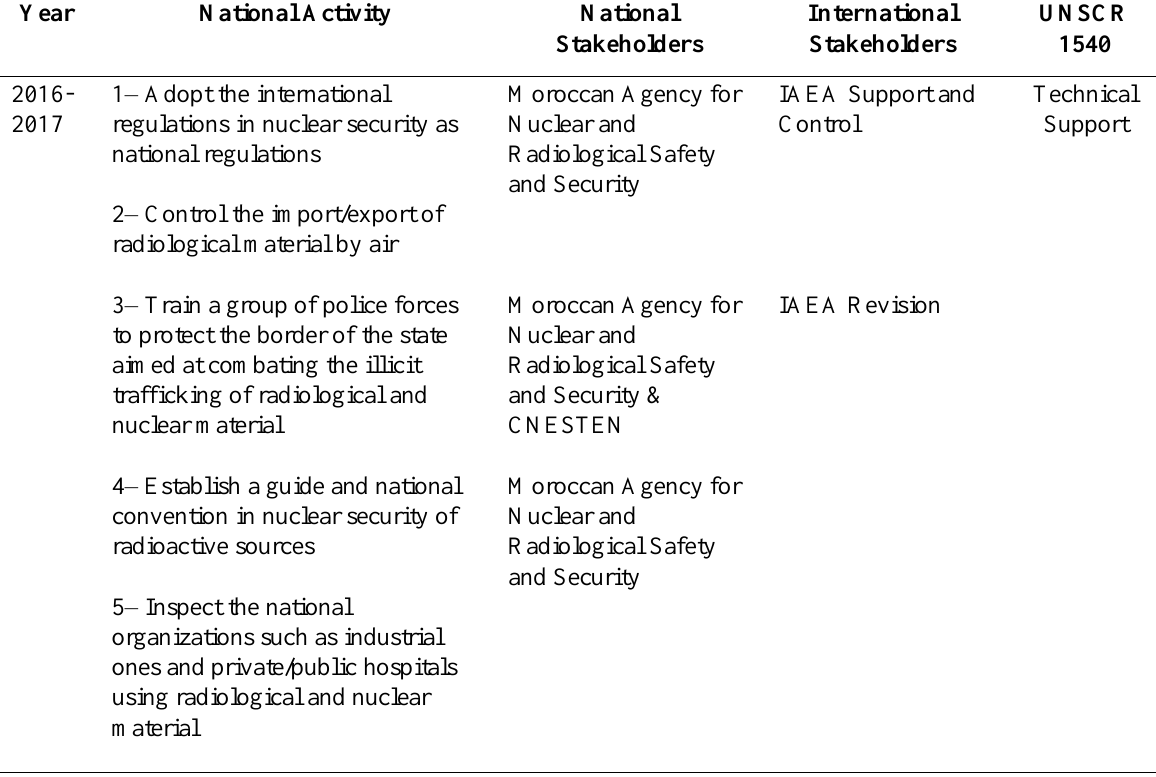
Table 2. 5-Year Plan Established to Prevent the Proliferation of Mass Destruction Year National